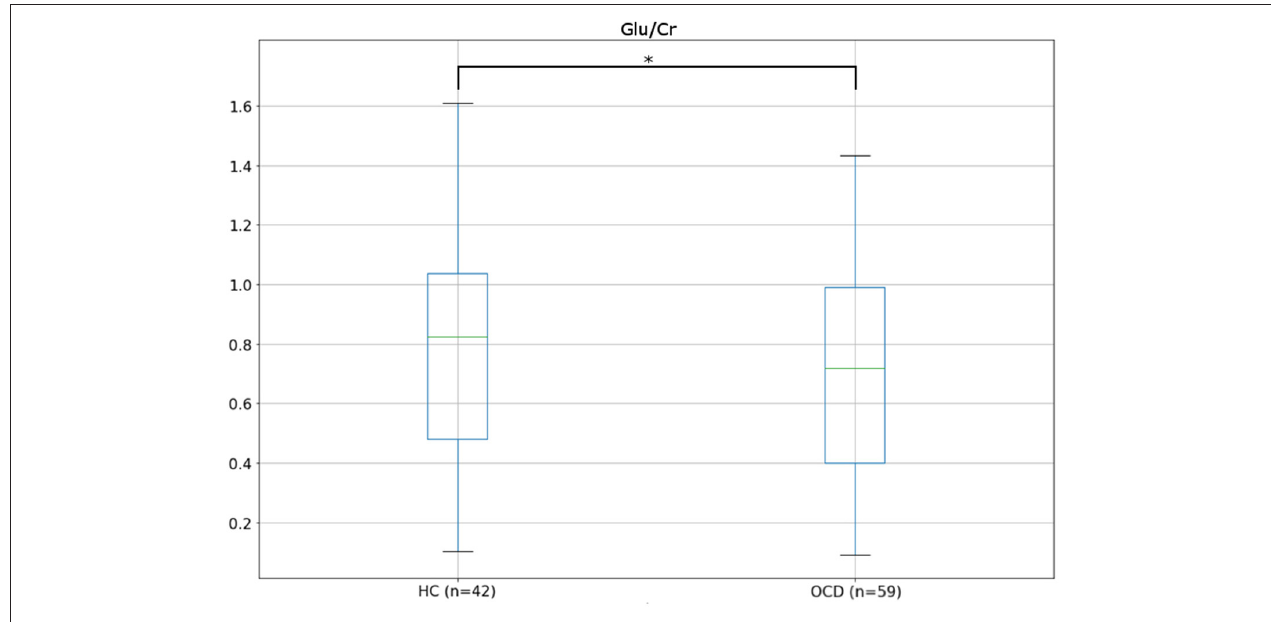
FIGURE 2 | Boxplots showing the distribution of Glu/Cr in healthy controls (HCs) and patients with obsessive–compulsive disorder (OCD).